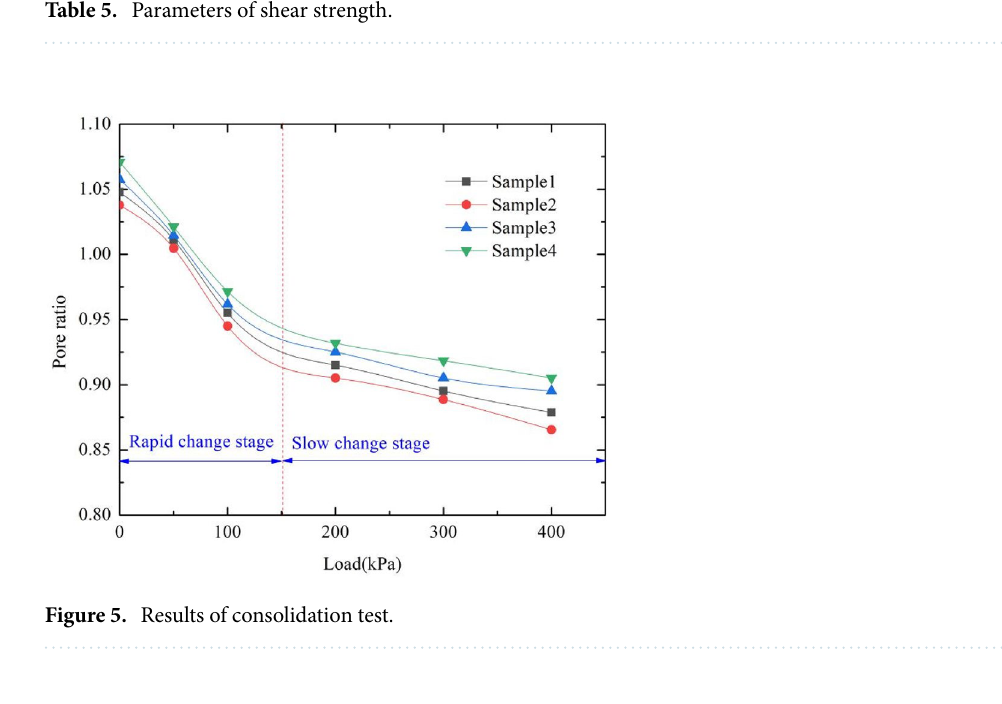
Table 5. Parameters of shear strength.